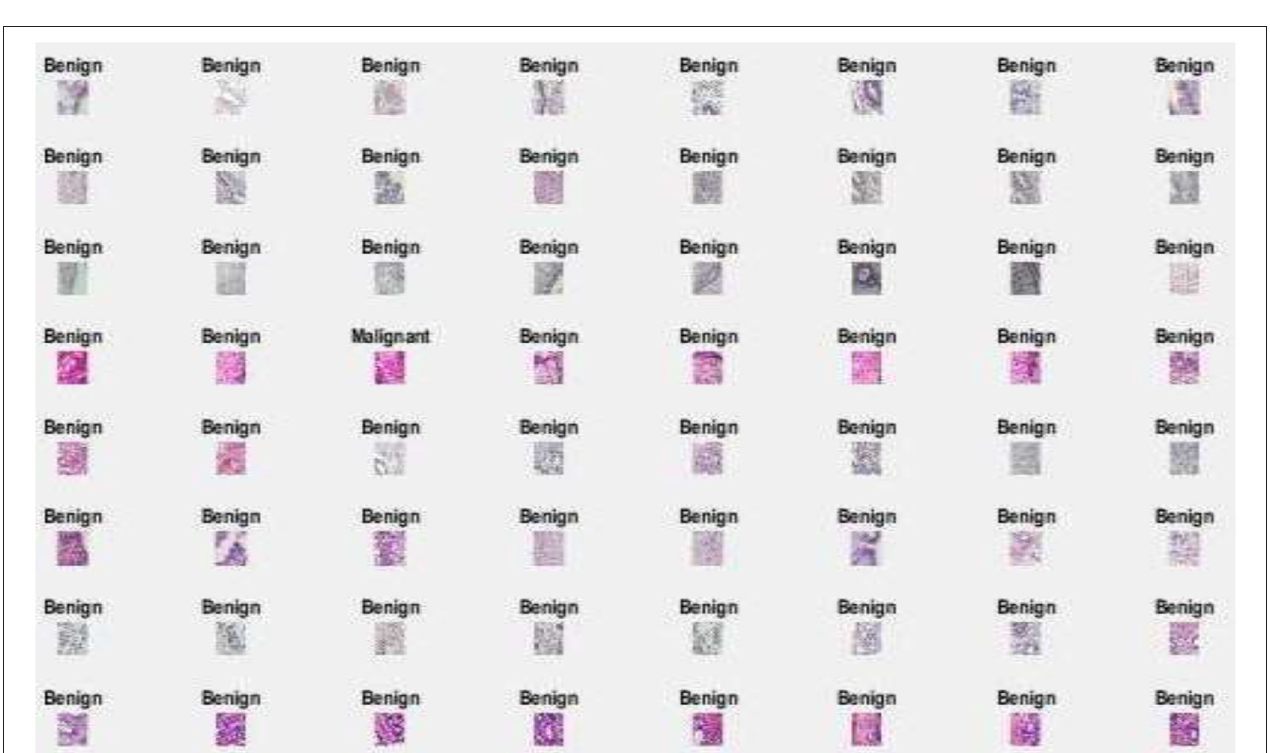
FIGURE 6 | Image classification of dataset